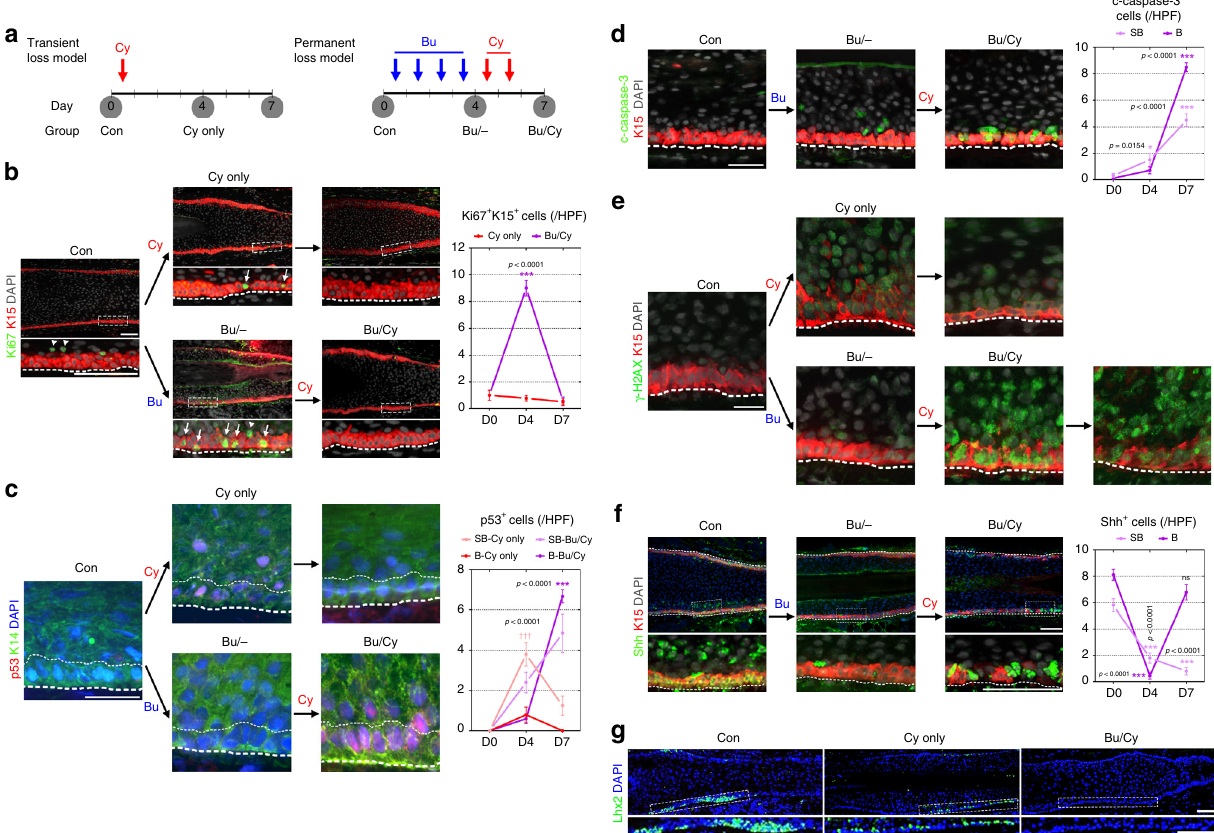
Fig. 3 Priming proliferation precedes loss of stem cell reserve in the bulge. a Experimental models for transient loss after Cy only treatment vs. permanent loss after Bu/Cy treatment. b Representative images and quanti fi cation of Ki67 + cells among K15 + HFSCs in the bulge ( n = 8 (D0 Con), 9 (D4 Cy only), 8 (D7 Cy only), 6 (D4 Bu), and 7 (D7 BuCy) biological replicates). Few Ki67 + cells were observed in the K15 ‒ suprabasal layer in control HFs (white arrowhead). HFSCs showed large-scale proliferation after Bu treatment (white arrow), and this proliferation was completely quenched after Bu/Cy treatment. c Representative images and quanti fi cation of p53 + cells in the K14 + HF epithelium in the bulge ( n = 6 (D0 Con), 5 (D4 Cy only), 4 (D7 Cy only), 5 (D4 Bu), and 6 (D7 BuCy) biological replicates). p53 + cells were observed in the suprabasal layer after Cy only treatment, but lining p53 + cells emerged in the basal layer after Bu/Cy treatment. d Representative images and quanti fi cation of c-caspase-3 + cells among K15 + HFSCs in the bulge ( n = 10 biological replicates/timepoint). Several c-caspase-3 + cells were detected in the K15 + basal layer after Bu/Cy treatment. e Representative images for γ -H2AX + cells among K15 + HFSCs in the bulge. γ -H2AX + cells were massively detected and persistent in the basal and suprabasal layers after Bu/Cy treatment. f Representative images and quanti fi cation of Shh + cells among K15 + HFSCs in the bulge ( n = 9 biological replicates/timepoint). Shh + cells disappeared after Bu treatment and then reappeared without K15 expression after Bu/Cy treatment in the basal layer. g Representative images of Lhx2 + cells in the bulge on day 13 after alkylating chemotherapy (immuno fl uorescence; scale bar = 100 μ m in b , f , g ; 50 μ m in c , d , e ). Bu busulfan, Cy cyclophosphamide, Bu/Cy busulfan followed by cyclophosphamide, SB suprabasal layer, B basal layer, HF hair follicle, HPF high-power fi eld, HFSC hair follicle stem cell, c-caspase-3 cleaved caspase-3. Data are mean ± SEM. Source data are provided as a Source Data fi le. *** p < 0.001 (Cy only vs. Bu/Cy), ††† p < 0.001 (SB vs. B, two-way analysis of variance with Sidak ’ s multiple comparisons test) in b and c ; * p < 0.05 (vs. D0), *** p < 0.001 (vs. D0, two-way analysis of variance with Sidak ’ s multiple comparisons test) in d and